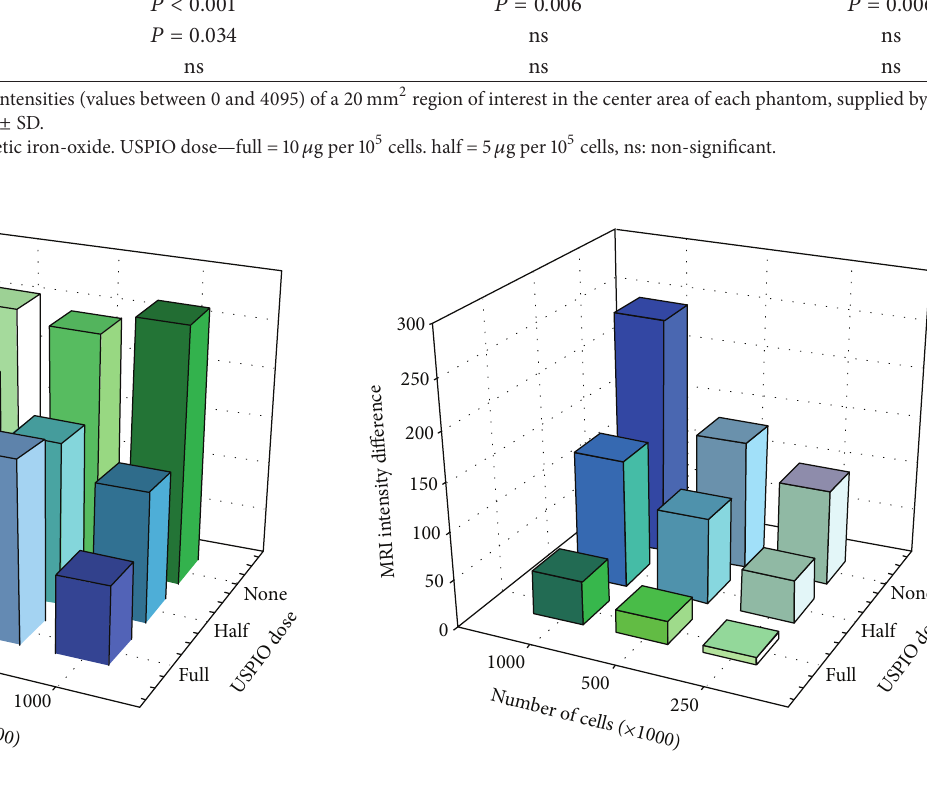
Figure 4: Phantoms intensity differences after 21-hour USPIO incu- bation. MRI intensity differences are the mean numeric difference between absolute MRI intensities of phantoms and reference gels. USPIO = ultrasmall superparamagnetic iron-oxide. USPIO dose: full = 10 𝜇 g per 10 5 cells; half = 5 𝜇 g per 10 5